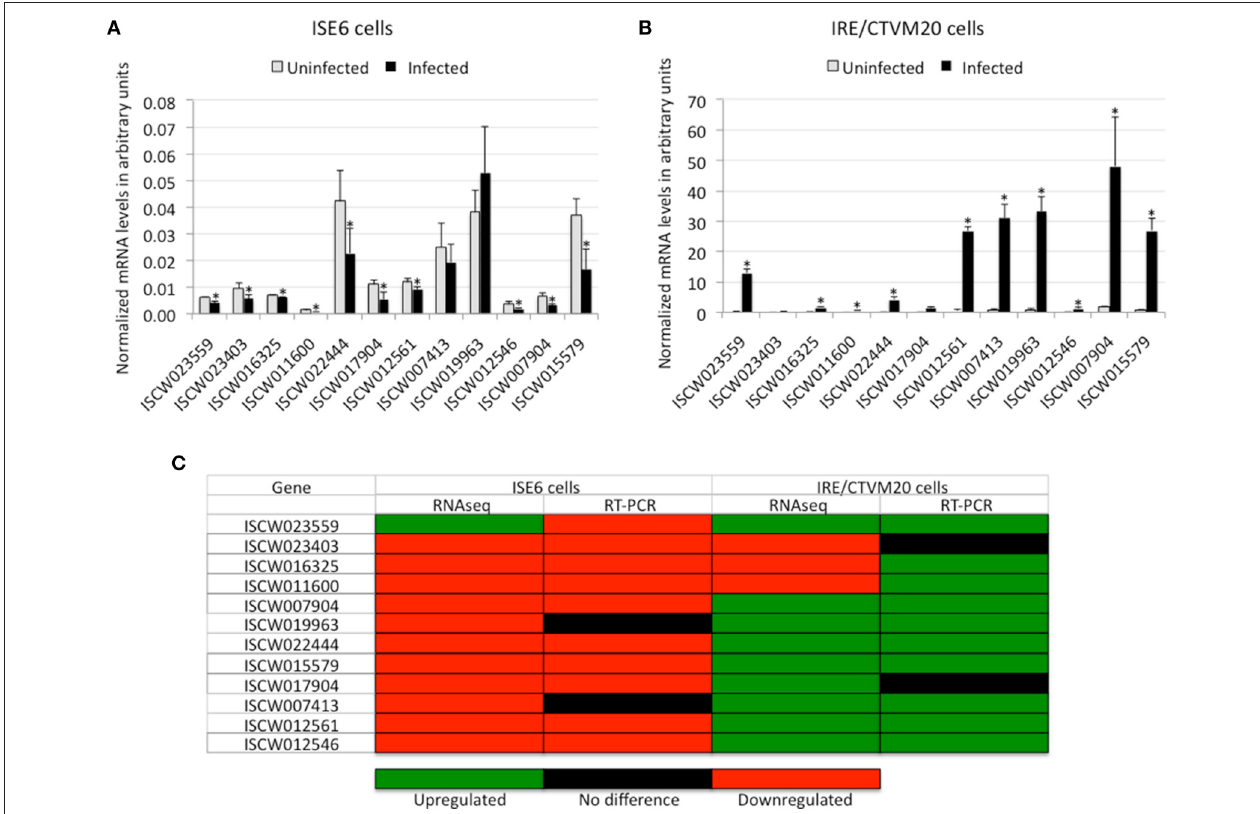
FIGURE 1 | Validation of RNAseq results. (A,B) The expression of selected differentially expressed genes was characterized by real-time RT-PCR using total RNA extracted from infected and uninfected ISE6 and IRE/CTVM20 tick cells. The mRNA levels were normalized against tick 16S rRNA and cyclophilin using the genNorm method. Normalized Ct -values were represented as average + S.D. and compared between infected and uninfected tick cells by Student’s t -test with unequal variance ( * P < 0.05 ; N = 5 biological replicates). (C) Comparison between RNAseq and real-time RT-PCR results showing a good correlation between both methods.